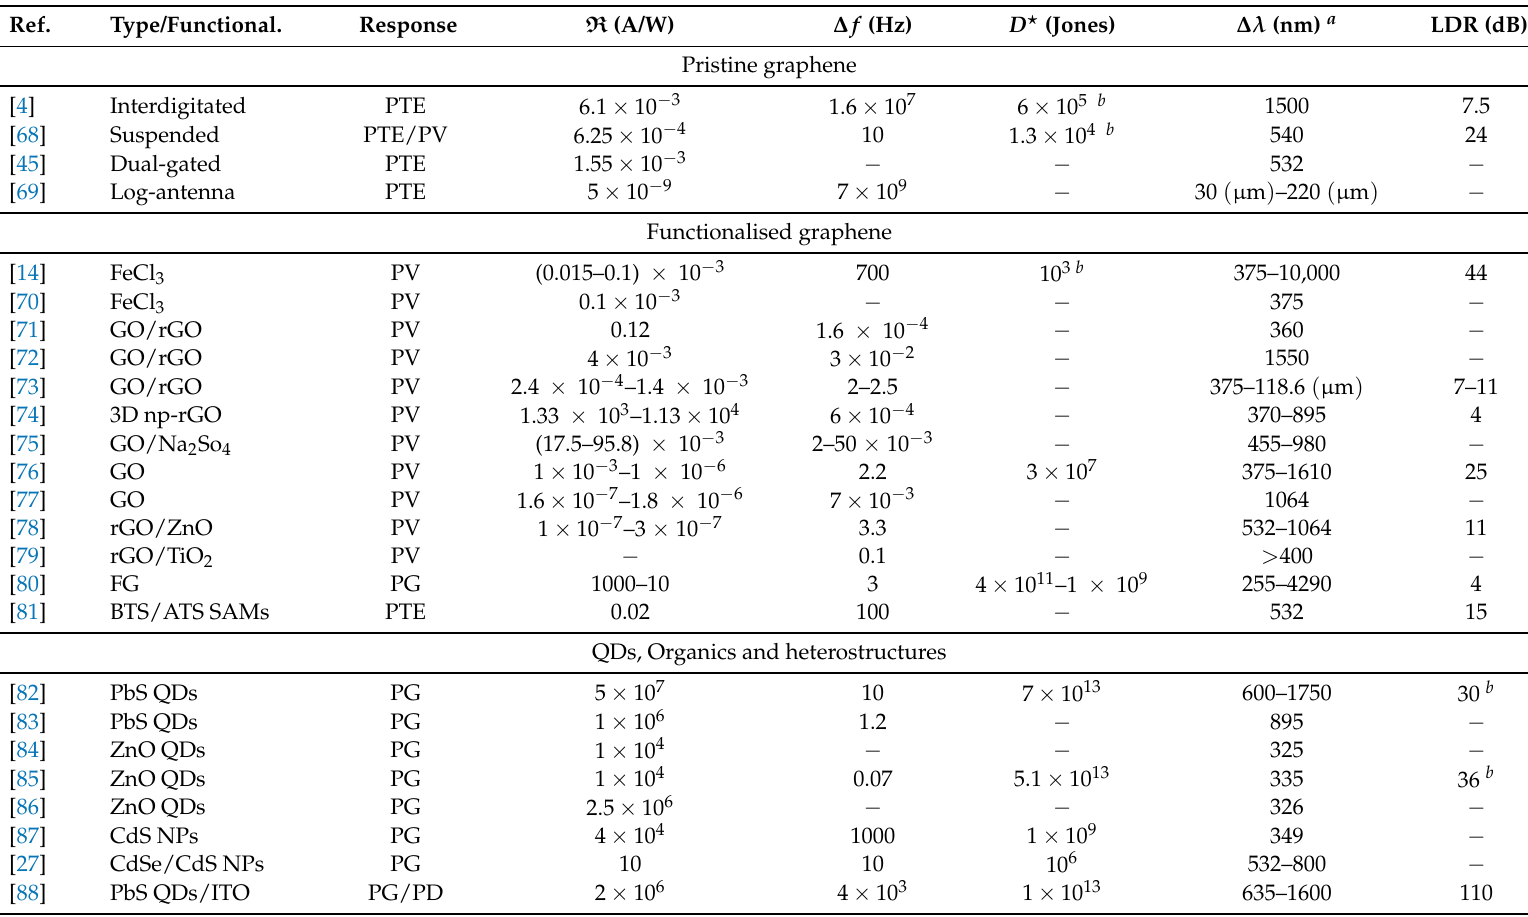
Table 2. Summary of key performance parameters for graphene, functionalised graphene and hybrid PDs. LDR and D ∗ values are reported only if available from the experimental data. Range of R , ∆ f , D (cid:63) and LDR are given corresponding to the range in ∆ λ .